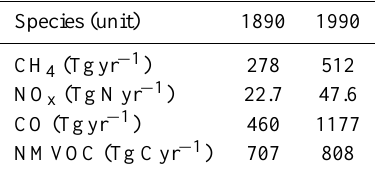
Table 3. Yearly emissions for 1890 and 1990 implemented in the model. Emission units are given in